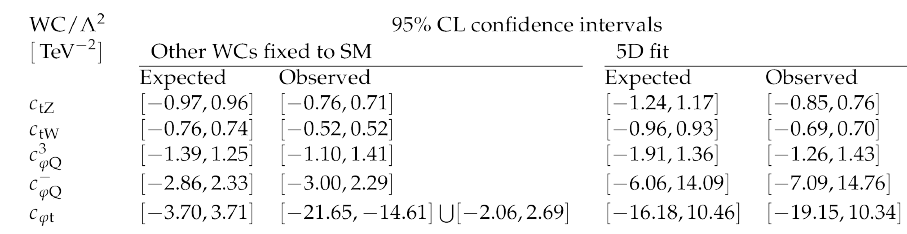
Figure 9. 95% CL confidence intervals for the 1D and 5D fits in [22].